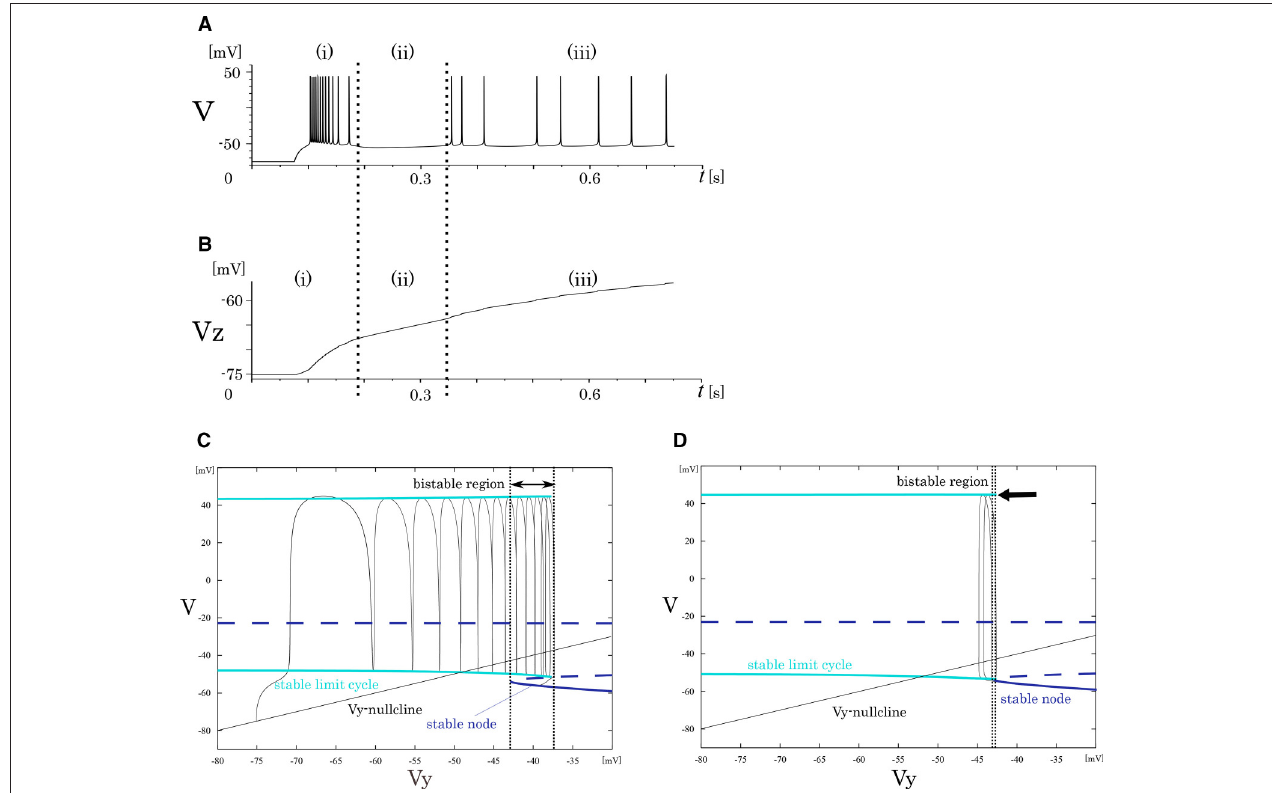
FIGURE 4 | Mathematical structure of the reduced model in the IB class. (A) Periodic spike waveform of the membrane potential in response to an excitatory step input. (B) Transition of the slowest variable V z that controls the mathematical structure of the fast system. The projected mathematical structure for the (C) V z = –70 mV and (D) V z = − 58